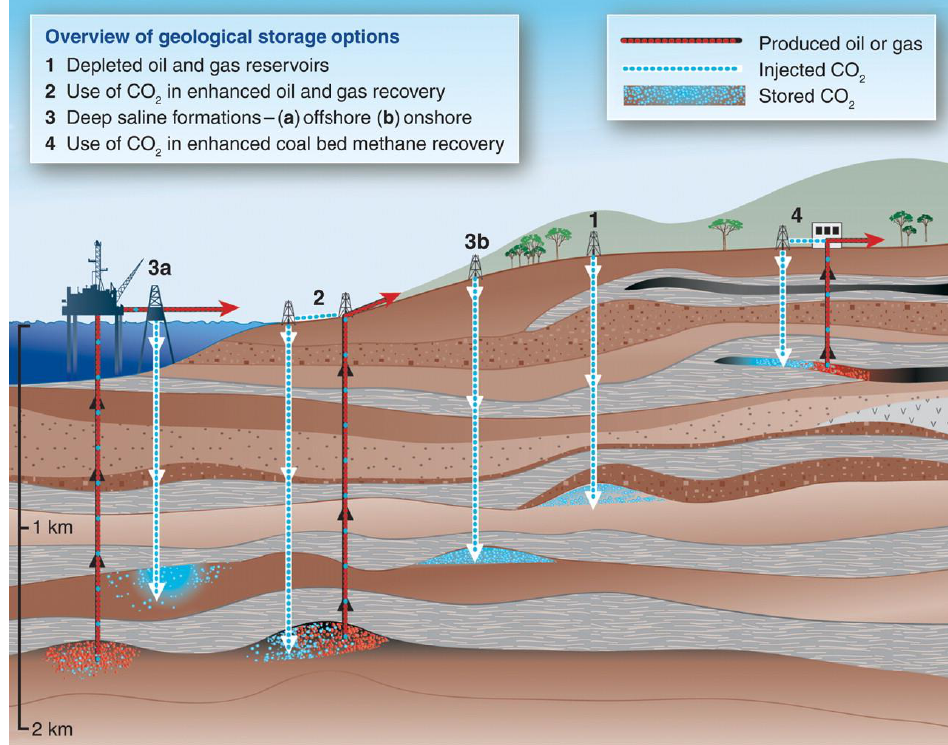
Figure 2. CO 2 storage options (taken from IPCC Special Report on Carbon Capture and Storage [26]).